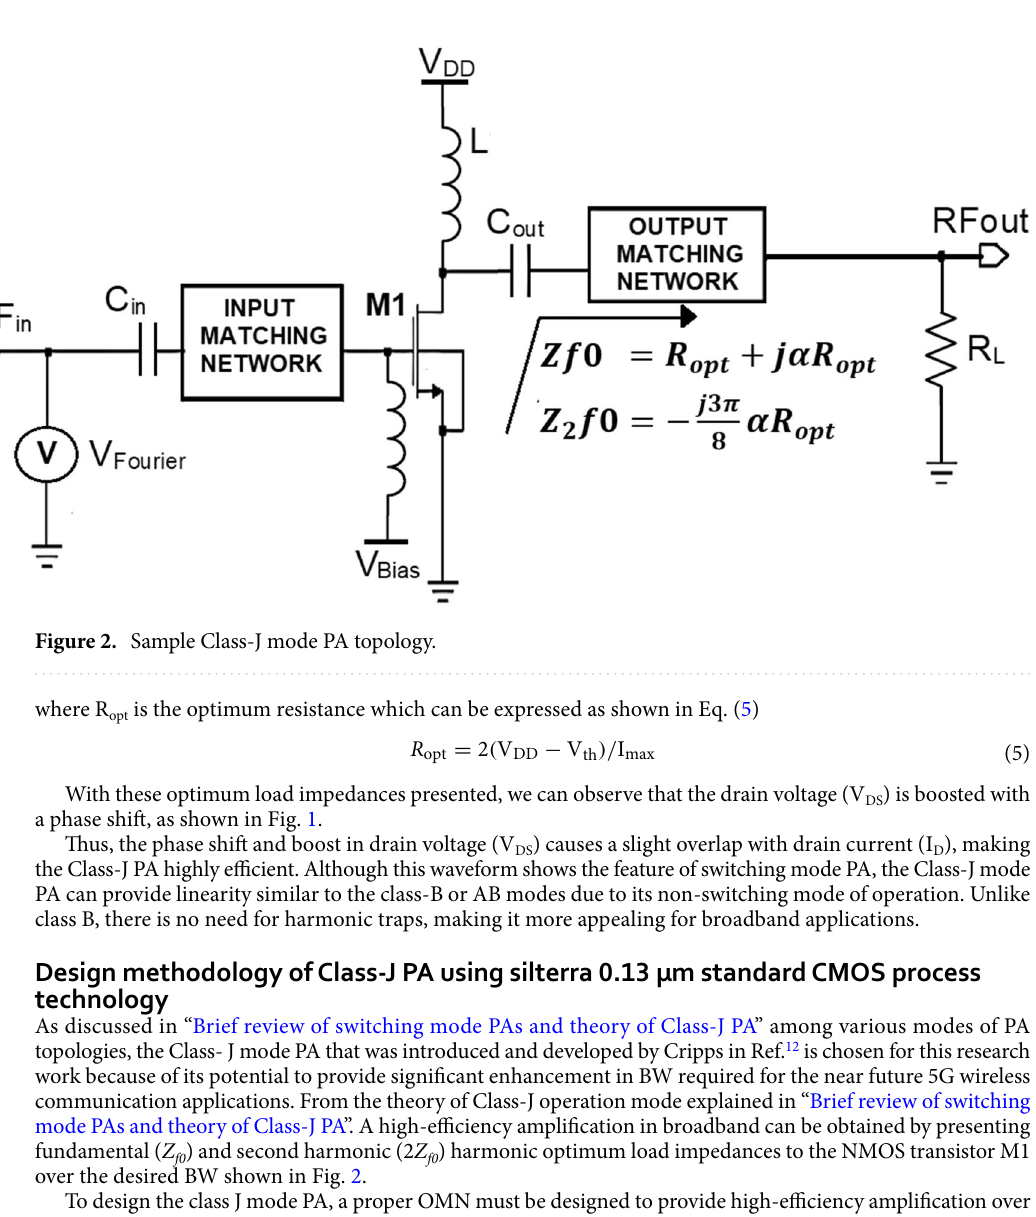
Figure 1. Class-J voltage and current waveforms at the drain of the transistor (V DS and I D ).